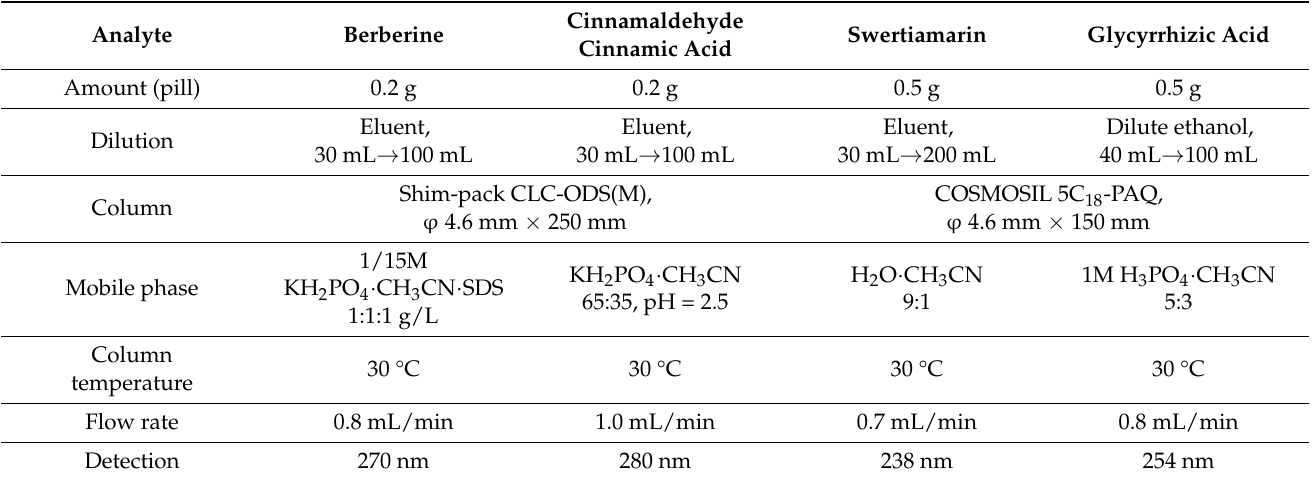
Table 1. Conditions for the high-performance liquid chromatography (HPLC) separation and detec- tion of the characteristic constituents for quality control—berberine, cinnamaldehyde, cinnamic acid, swertiamarin, and glycyrrhizic acid, in the sample